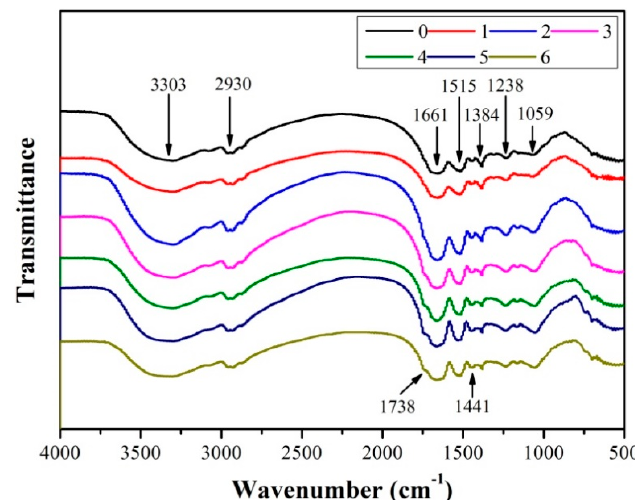
Figure 5. Fourier-transform infrared spectra of the different adhesive samples: 0 (12 wt% SPI), 1 (18 wt% SPI/bromelain), 2 (18 wt% SPI/bromelain/3 wt% TGA), 3 (18 wt% SPI/bromelain/6 wt% TGA), 4 (18 wt% SPI/bromelain/9 wt% TGA), 5 (18 wt% SPI/ bromelain/12 wt% TGA), and 6 (18 wt% SPI/9 wt% TGA).